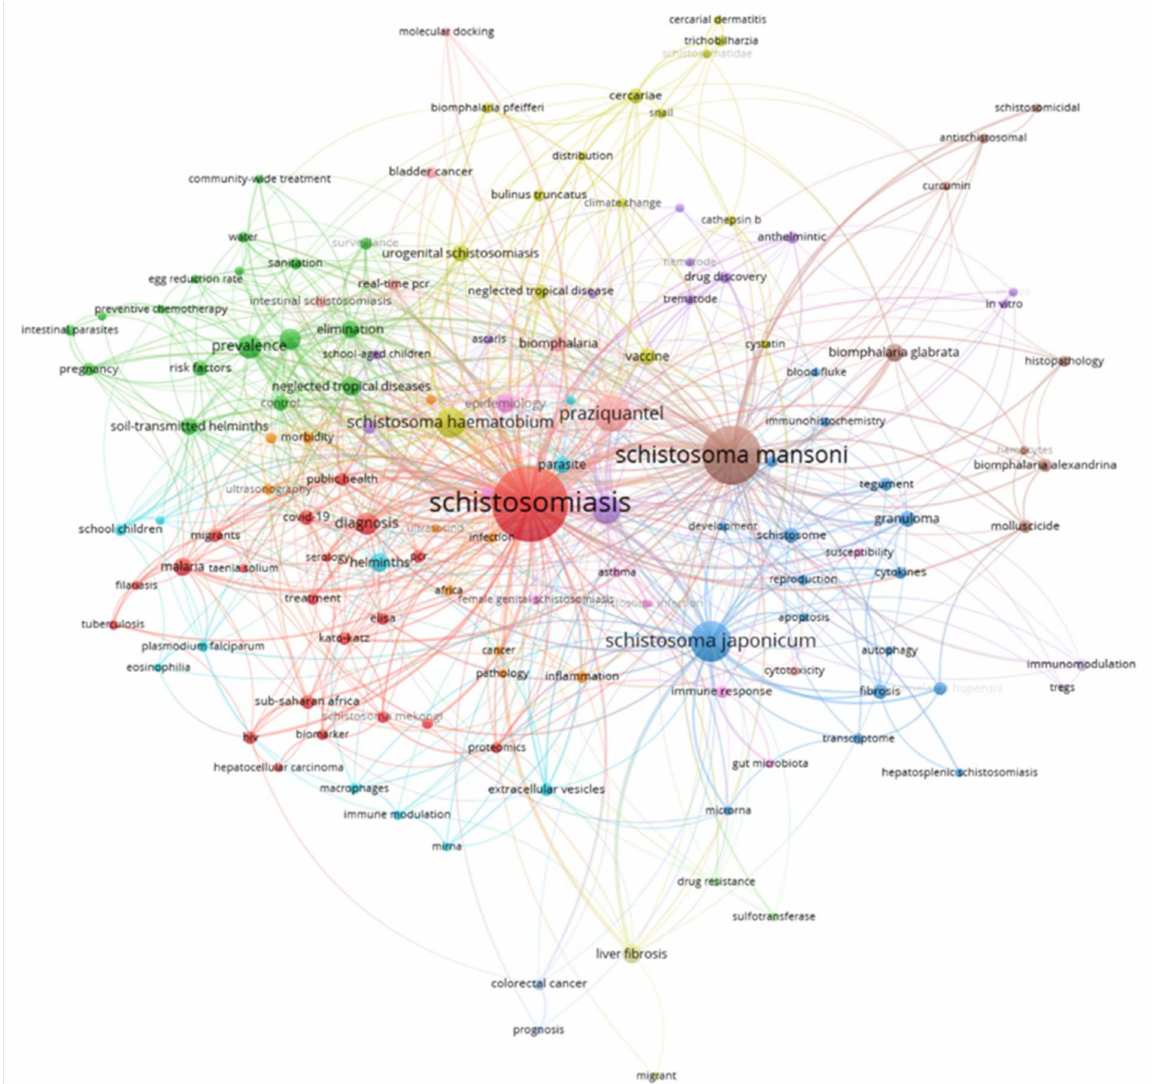
Figure 8. Co-occurrence network of